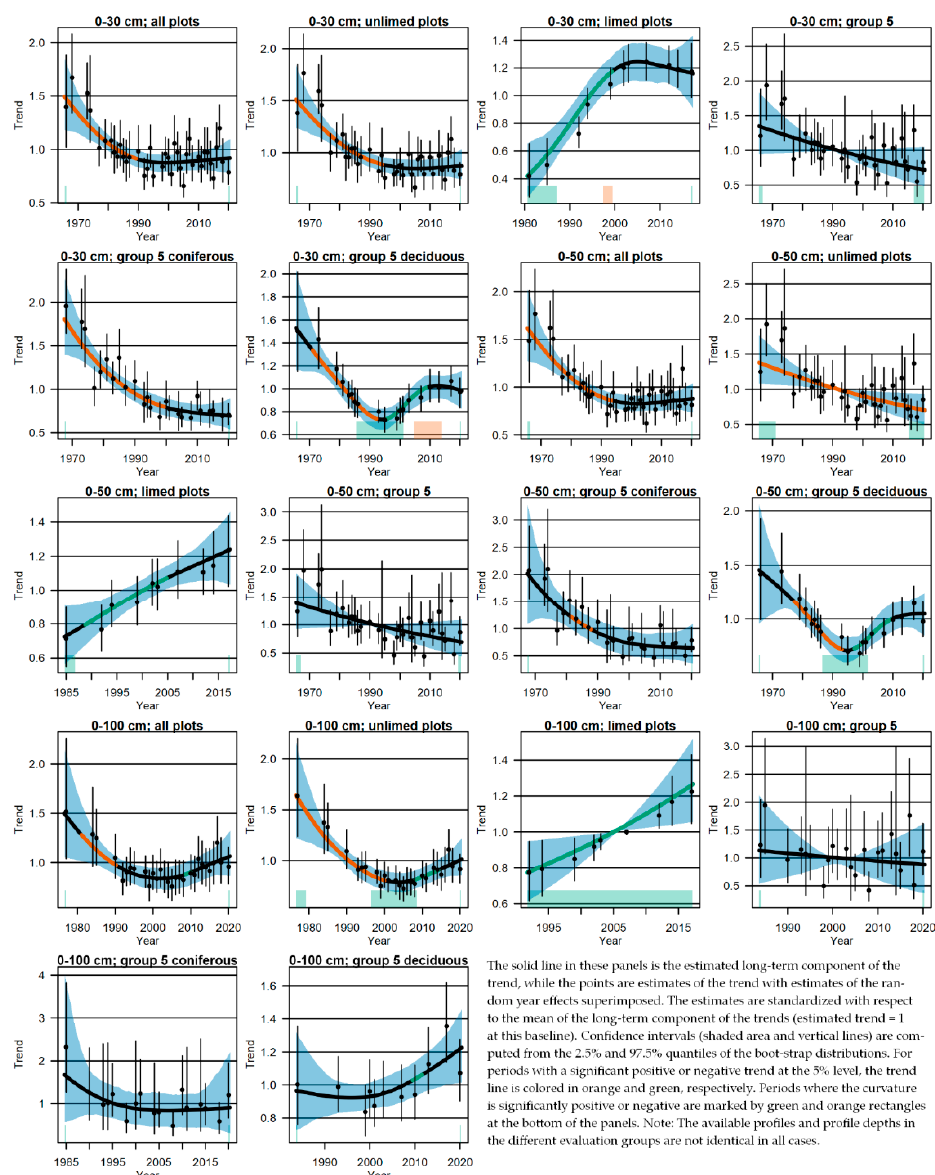
Figure 9. Estimated trends for the base saturation in mineral soil for different aggregation depths (0–30 cm, 0–50 cm, and 0–100 cm). (0–30 cm, 0–50 cm, and 0–100